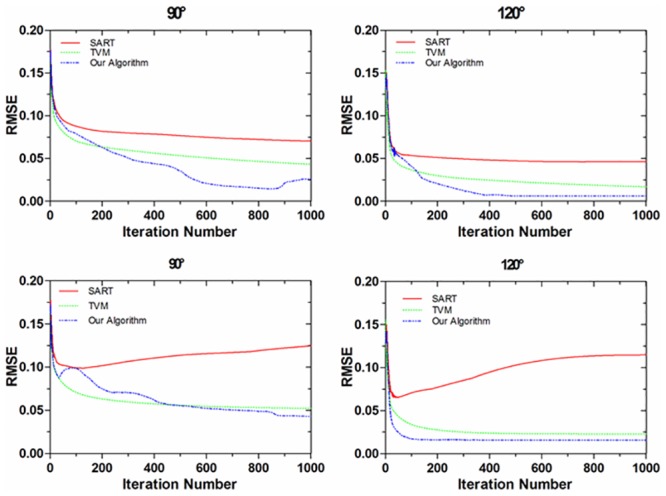
RMSE curves of NCAT phantom reconstructions by SART algorithm, TVM algorithm and our algorithm for one typical phase of the NCAT phantom.The graphs on top row and bottom row present the RMSE curves of the results reconstructed from noise-free projection dataset and noisy projection dataset respectively. The graphs from left to right in each row present the RMSE curves of the results reconstructed from scanning angular ranges [0, 90°] and [0, 120°], respectively.